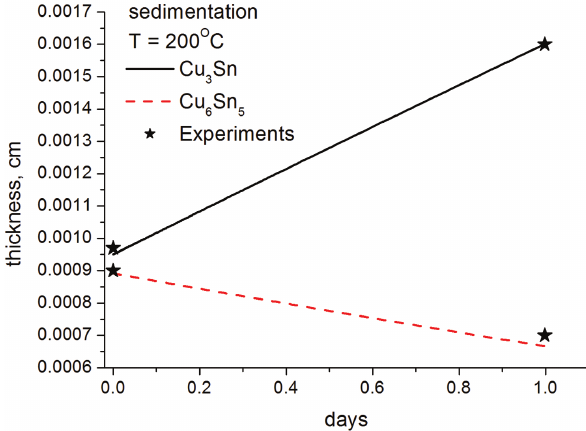
Figure 4: Kinetics of the Cu 6 Sn 5 and Cu 3 Sn growth after the sedi- mentation process at 200°C after 24h.